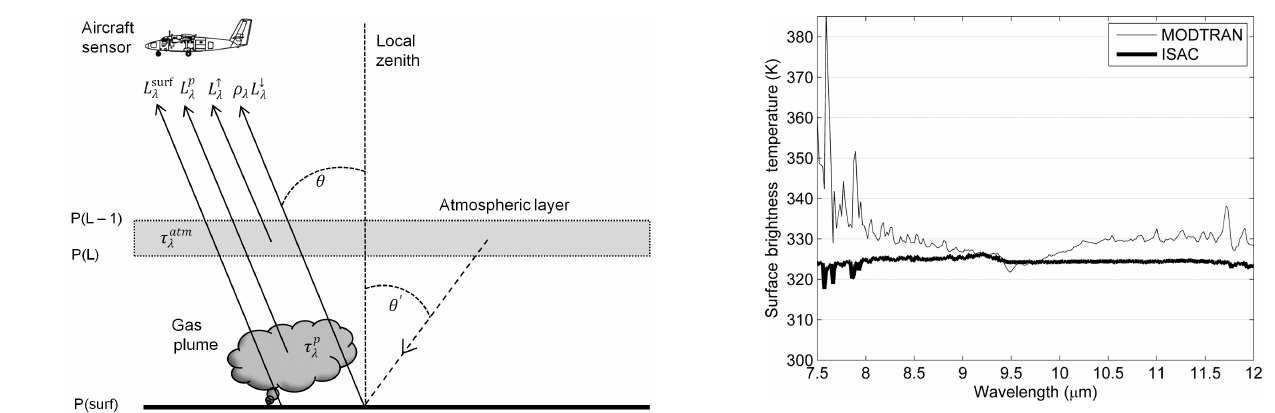
Figure 4. An example of surface brightness temperature spec- Figure 3. Illustration depicting various components of thermal in- tra from HyTES after atmospheric correction using the RTM ap- frared radiative transfer with a gaseous plume, where L surf is the λ proach with MODTRAN (gray line), and the ISAC approach (black ↑ Earth-emitted radiance, L p is the plume thermal emission term, L line). With a successful atmospheric correction we expect a nearly λ λ ↓ constant temperature across all bands, which is achievable with the atmospheric path radiance, ρ λ L the reflected downwelling ra- λ the ISAC approach but not with MODTRAN below 8µm and the plume transmit- diance, τ atm the atmospheric transmittance, τ p λ λ above 11.5µm because of misregistrations between HyTES data tance, θ the observation angle, and P(*) the pressure level. and